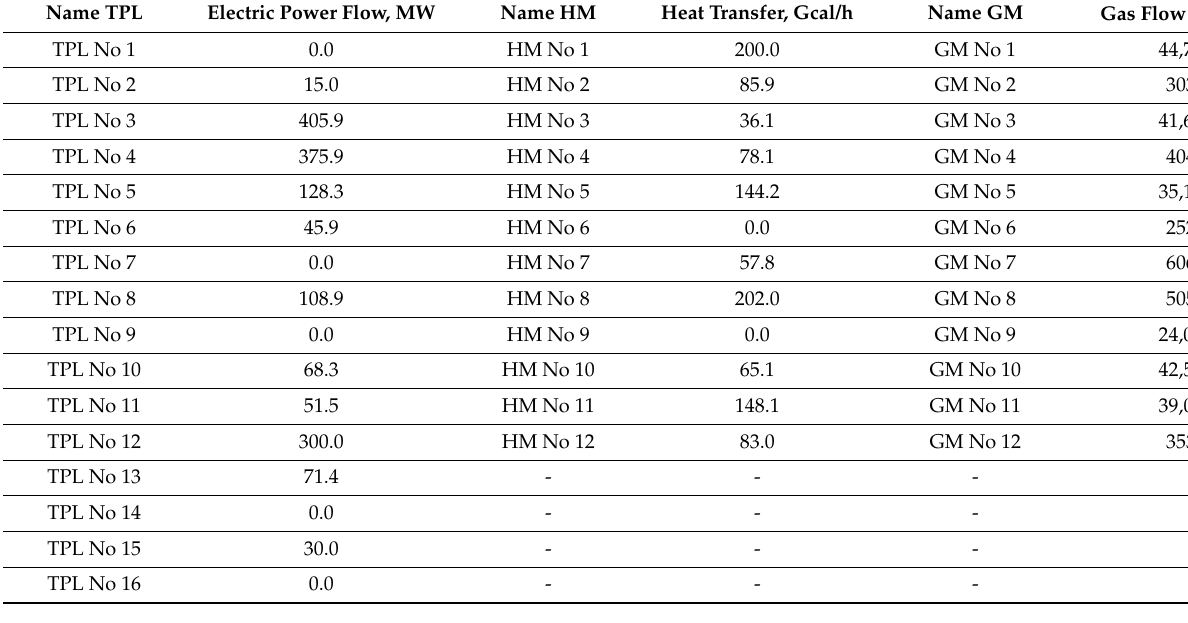
Table 3. Calculation results for network sections.